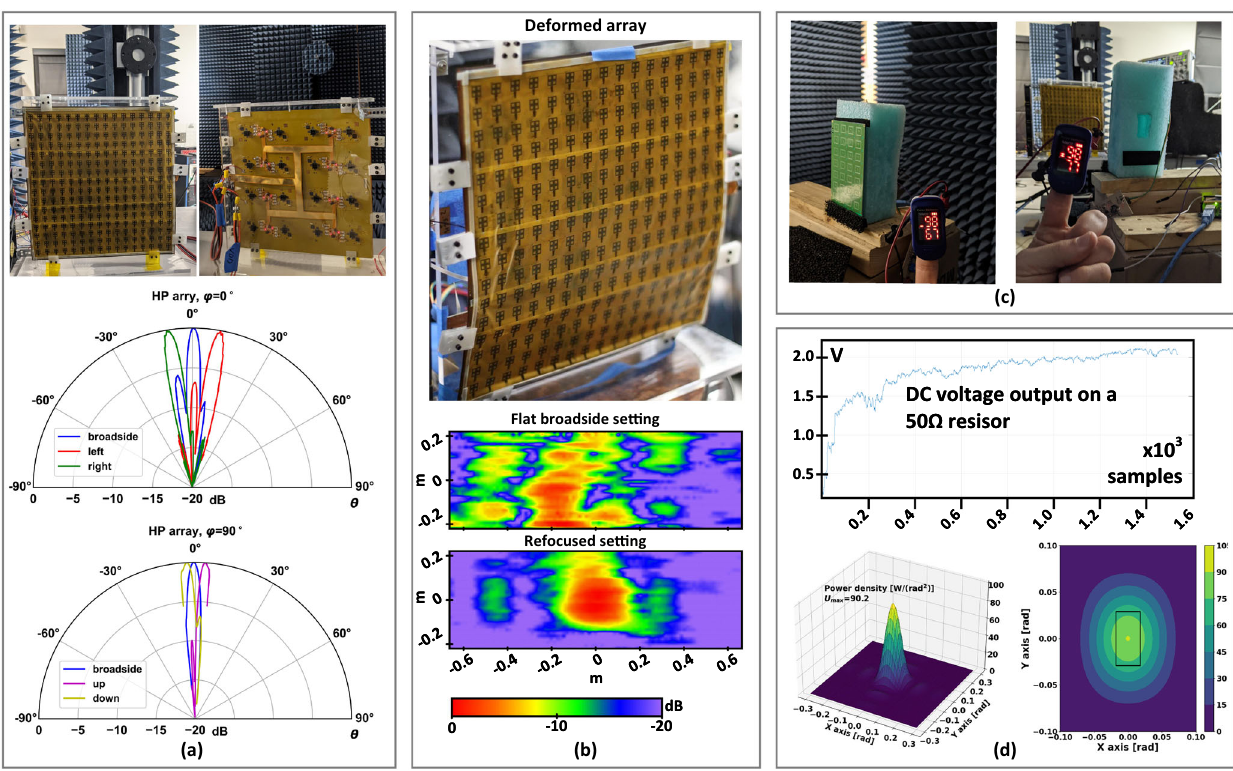
Fig. 4 Antenna sheet array measurements. a Beam-steering, b deformation correction, c RF-DC wireless power transfer of about 80 mW at 1 m away from the transmitter to a small rectenna array. d Measured output voltage on a 50 Ω resistor, 1 m away from the array (top), angular power density (bottom-left) and expected power delivery distribution to the remote receiver at ~1.6 m away from the array